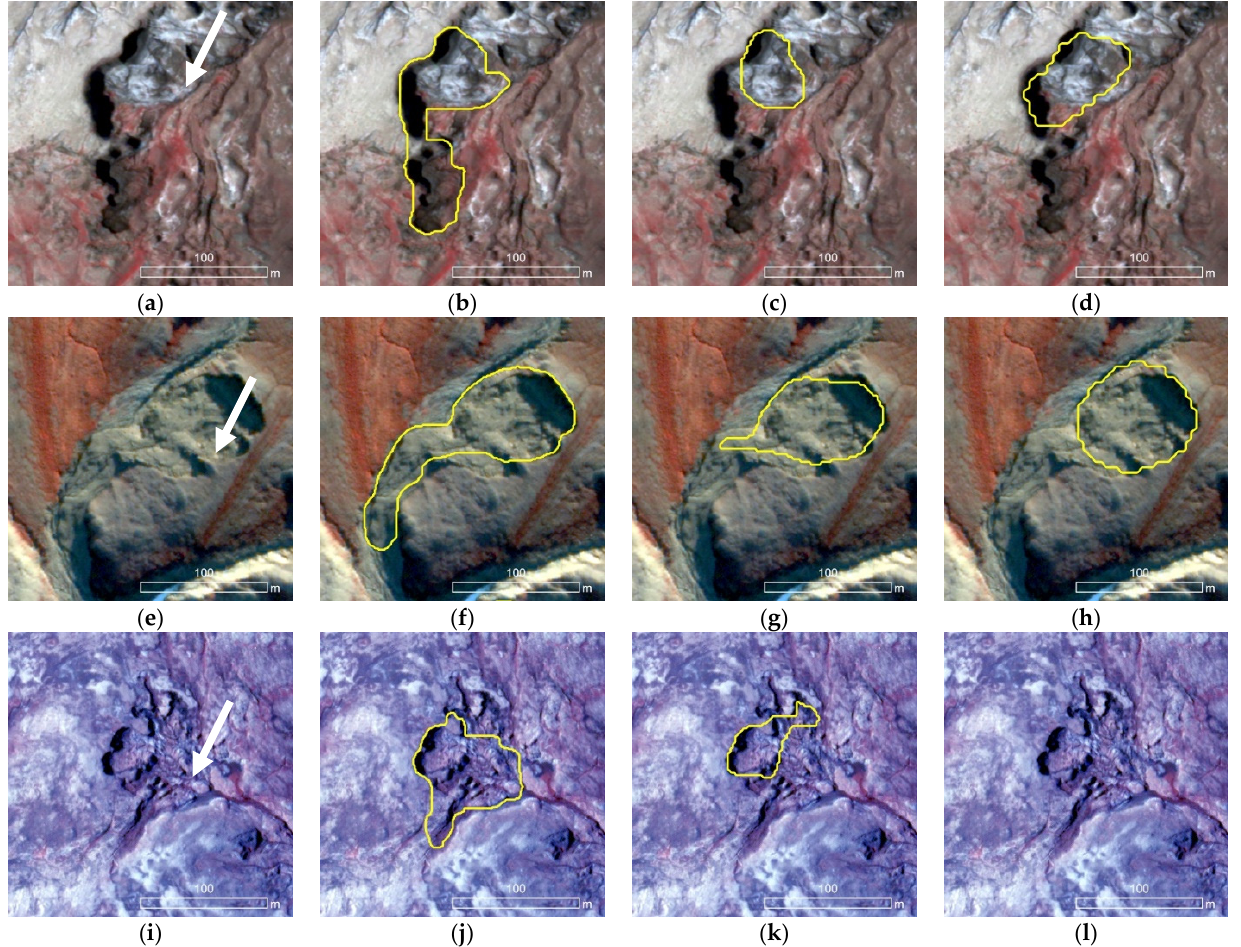
Figure 16. Example zoomed-in views of DLCNN model predictions on the test data from selected location of Banks Island and the Eureka Sound Lowlands. Examples exhibit training and prediction of input image tiles 2048 × 2048 ( a , e , i ) with resizing into 3 different network input sizes: 1024 × 1024 ( b , f , j ); 512 × 512 ( c , g , k ), and 256 × 256 ( d , h , l ). Outline of the predicted RTS is shown in yellow. White arrows indicate the location of the RTS. Underlying imagery is at 0.5 m resolution as false color composites.